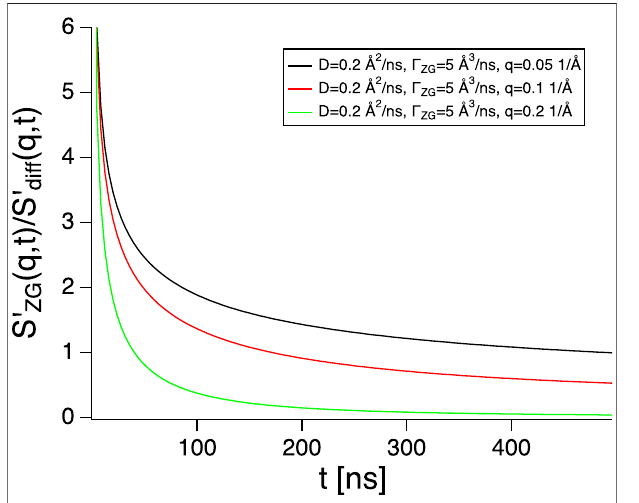
FIGURE 2 | Intermediate scattering functions for diffusion ( S diff ( q , t ), full lines) and membrane undulations ( S ZG ( q , t ), dashed lines) using parameters indicated in the graph. Diffusion gives a non-negligible contribution.